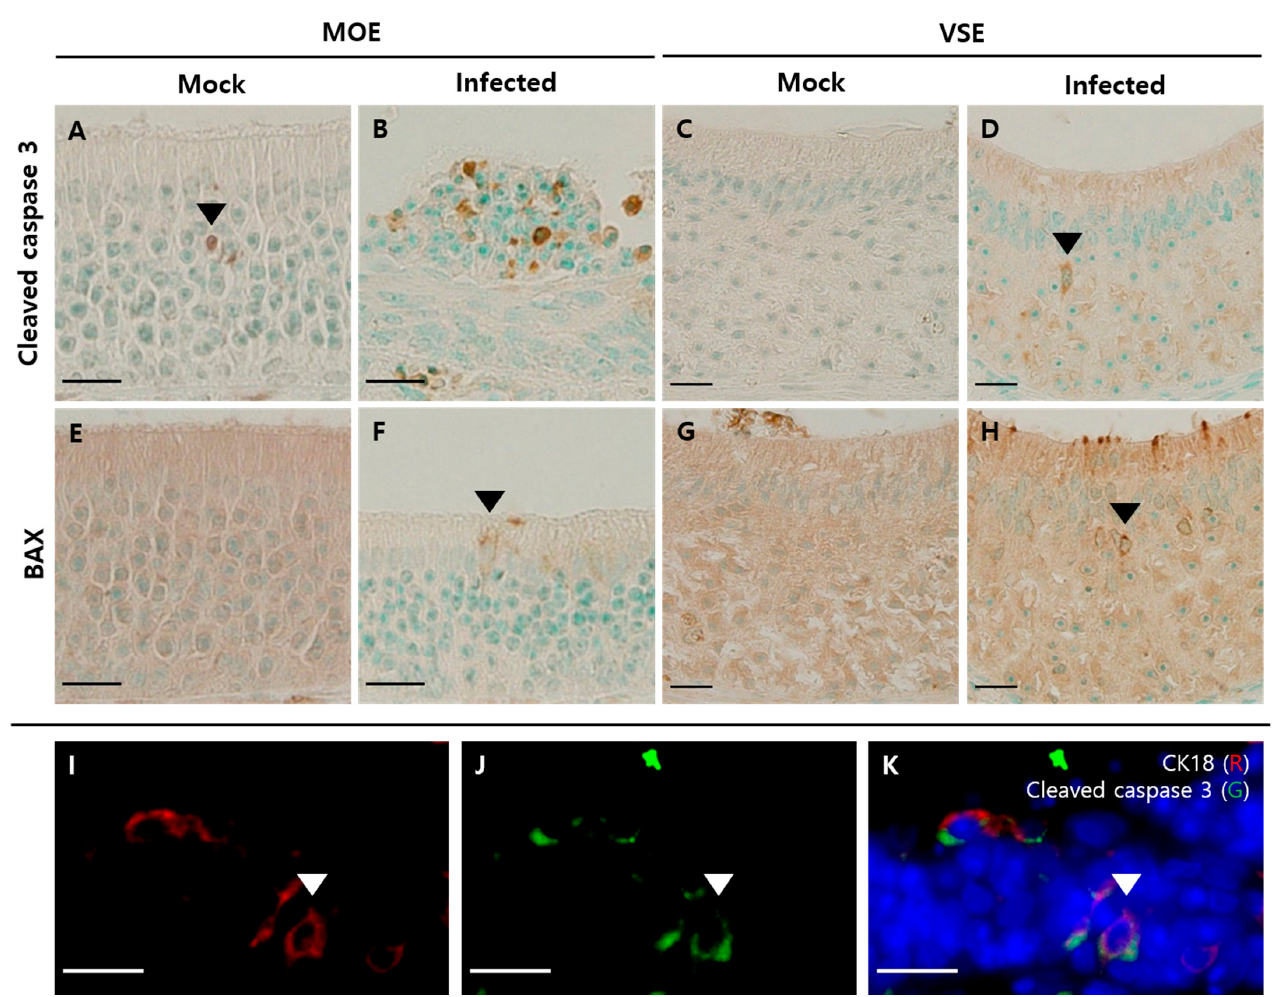
Figure 7. Apoptosis in the olfactory system. Scale bars = 20 μ m. ( A ) DAB staining with the antibody against cleaved caspase 3 in the MOE of the mock group. Few cleaved caspase 3-positive cells were observed in the intermediate region of the MOE; ( B ) DAB staining with the antibody against cleaved caspase 3 in the MOE of the infected group. Increased cleaved caspase 3-positive cells were present in various layers of the MOE and cell debris; ( C ) DAB staining with the antibody against cleaved caspase 3 in the VSE of the mock group. There were few cleaved caspase 3-positive cells; ( D ) DAB staining with the antibody against cleaved caspase 3 in the VSE of the infected group. The nuclei of cleaved caspase 3-positive cells appeared as the nuclei of SCs; ( E ) DAB staining with BAX antibody in the MOE of the mock group. There were few BAX-positive cells in the MOE; ( F ) DAB staining with the antibody against BAX in the MOE of the infected group. The nucleus of BAX-positive cells was in the apical layer and resembled the nuclei of SCs; ( G ) DAB staining with the antibody against BAX in the VSE of the mock group. There were few BAX-positive cells in the VSE; ( H ) DAB staining with the BAX antibody in the VSE of the infected group. The nucleus of BAX-positive cells was in the apical layer and resembled the nuclei of SCs. ( I – K ) Double immunofluorescence with the antibody against CK18 (red) and cleaved caspase 3 (green) in the MOE of the infected group. Sections were counterstained with DAPI (blue). Some CK18-positive cells colocalized with cleaved caspase 3.